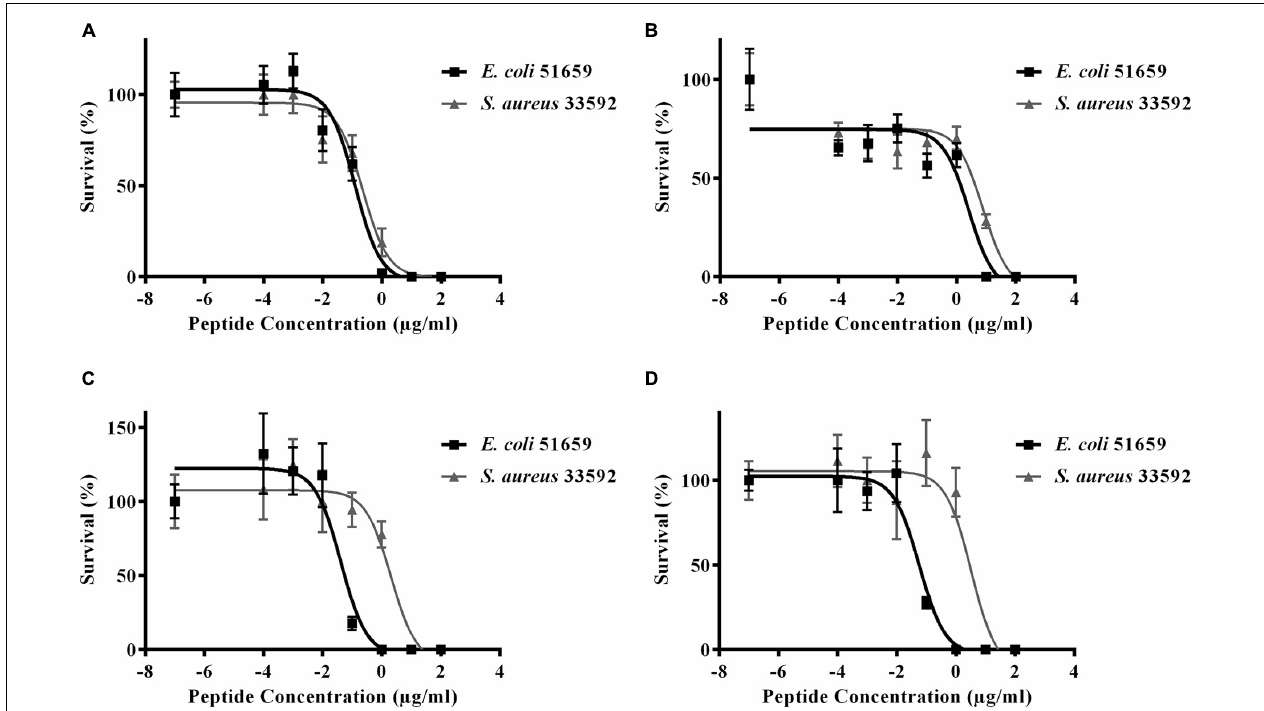
FIGURE 5 | Half maximal effective concentration (EC 50 ) of (A) PHNX-1, (B) PHNX-6, (C) PHNX-7, and (D) PHNX-8 against antibiotic resistant E. coli O157:H7 51659 and S. aureus MRSA